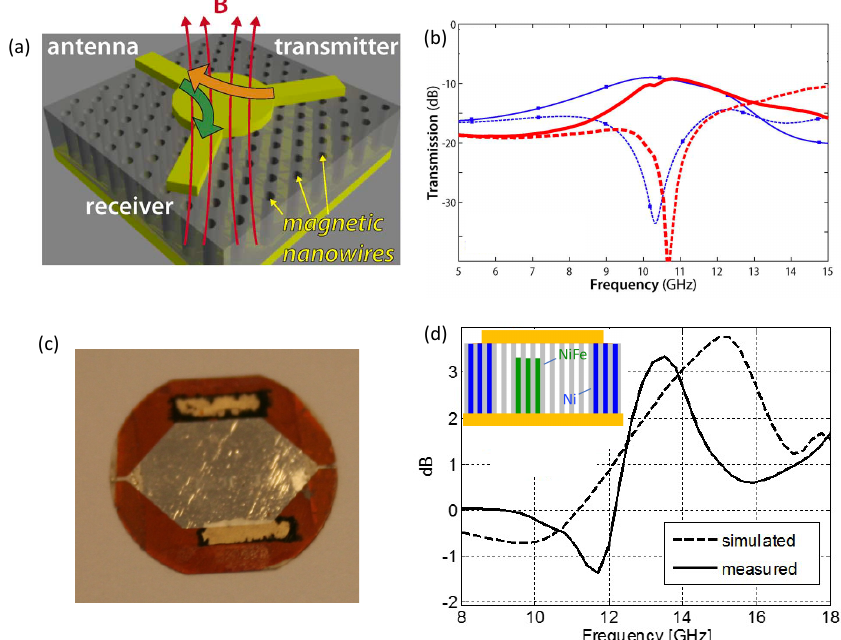
Figure 17. ( a ) sketch of a microwave circulator based on an unbiased ferromagnetic nanowires array embedded in a porous anodic alumina membrane; ( b ) measured (red) and predicted (blue squares) results for a circulator based on a ferromagnetic NiFe NW array (adapted from [51]); ( c ) photograph of a substrate integrated waveguide (SIW) resonance isolator device using ferromagnetic NW grown in nanoporous alumina; ( d ) isolation, defined as the ratio expressed in dB between forward |S21|and reverse |S12| transmissions of signal ( I = 20log (dashed line) and observed experimentally (solid line) are shown; the positive value of isolation confirms that transmission is favored from port 1 to port 2 (adapted from [52]). Figure adapted from refs [51,52] with permission of the